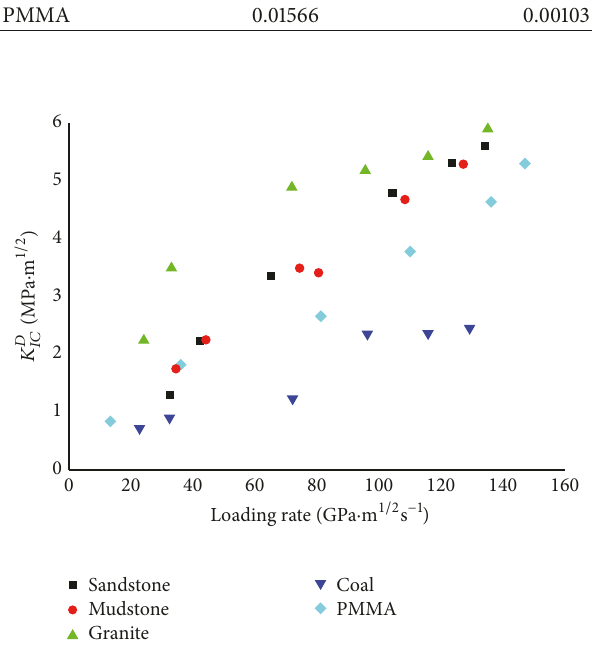
Figure 7: Test results of the dynamic fracture toughness for several typical